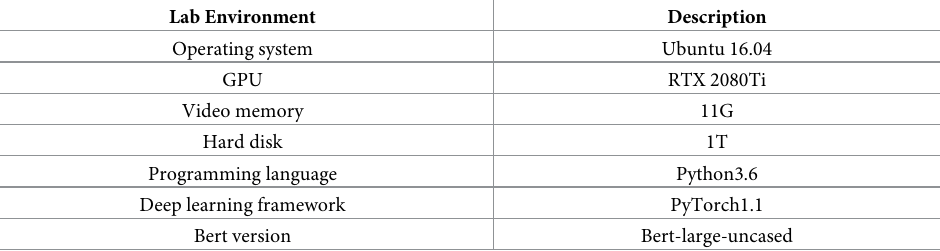
Table 4. The experimental environment and